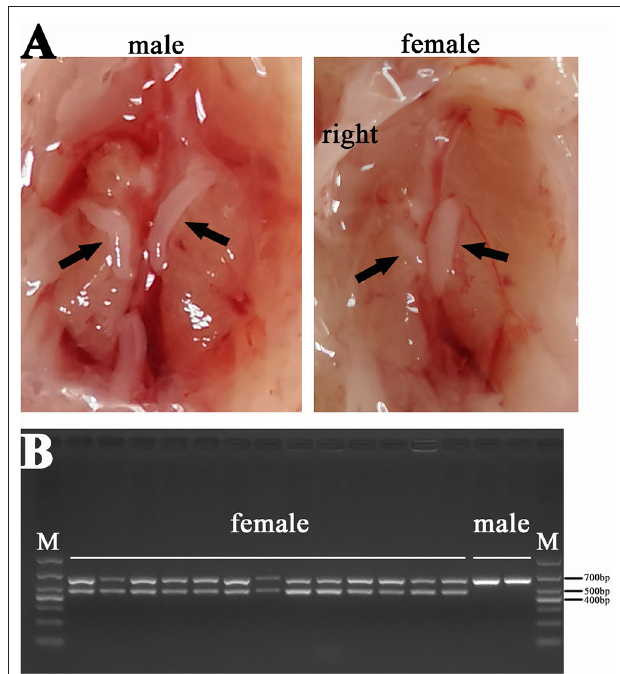
FIGURE 2 | Sex identification results of chicken (A) Comparison between male and female gonads: the gonads on both sides of the male chicken develop normally, and the gonads on the right side of the female chicken degenerate; (B) Results of PCR for CHD1 gene: two bands were female chicken (ZW) and one band was male chicken